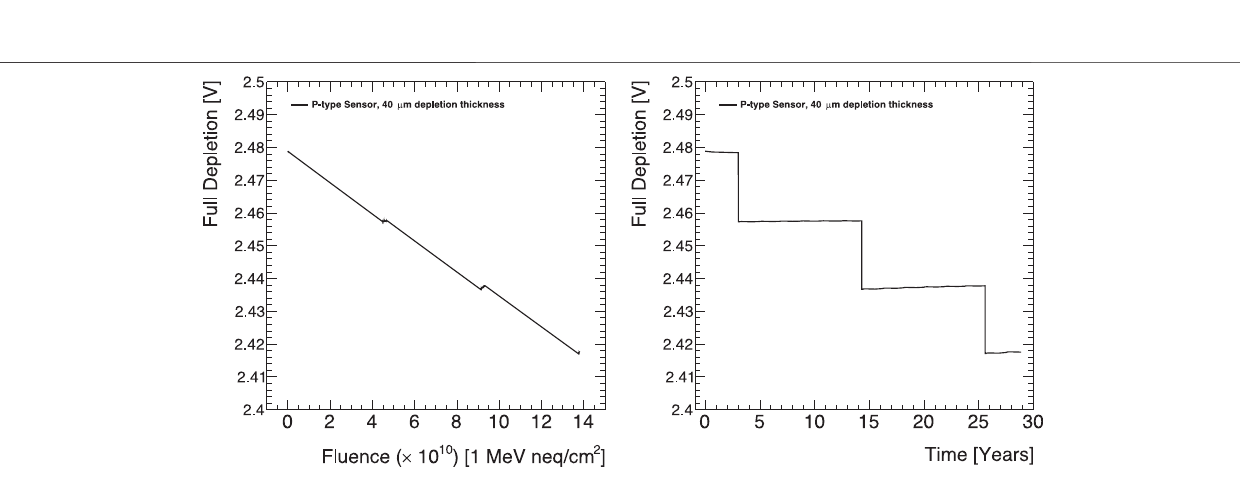
FIGURE 6 | Depletion voltage as a function of (left) integrated charged particle fl uence, and (right) time in Earth-years, for an p-type silicon sensor of depletion depth 40 μ m.